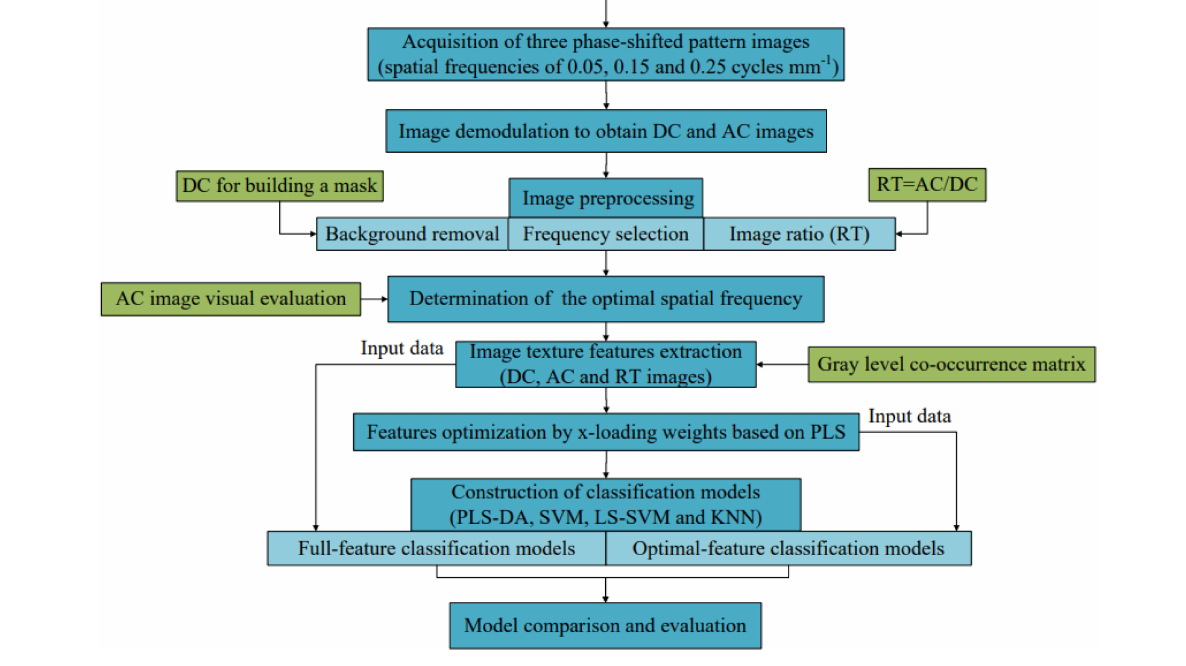
FIGURE3 Flowchart for detection of the decayed oranges.